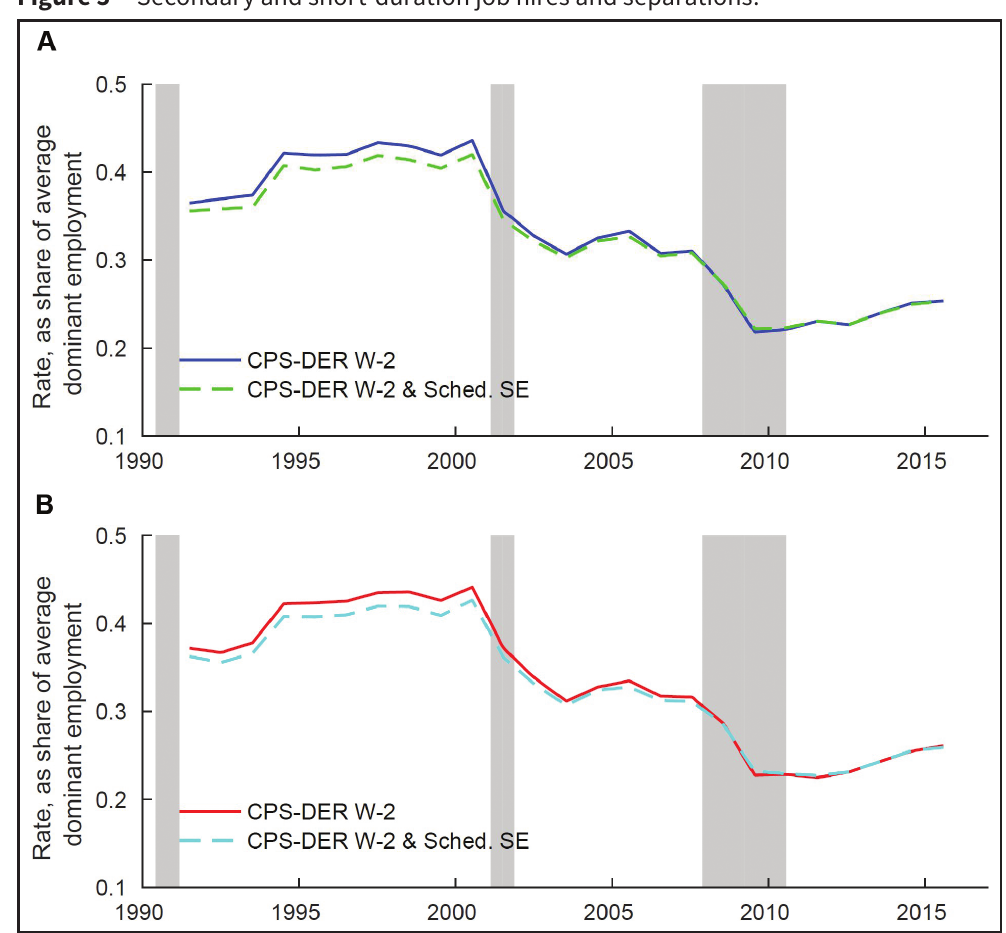
Figure 5 Secondary and short-duration job hires and